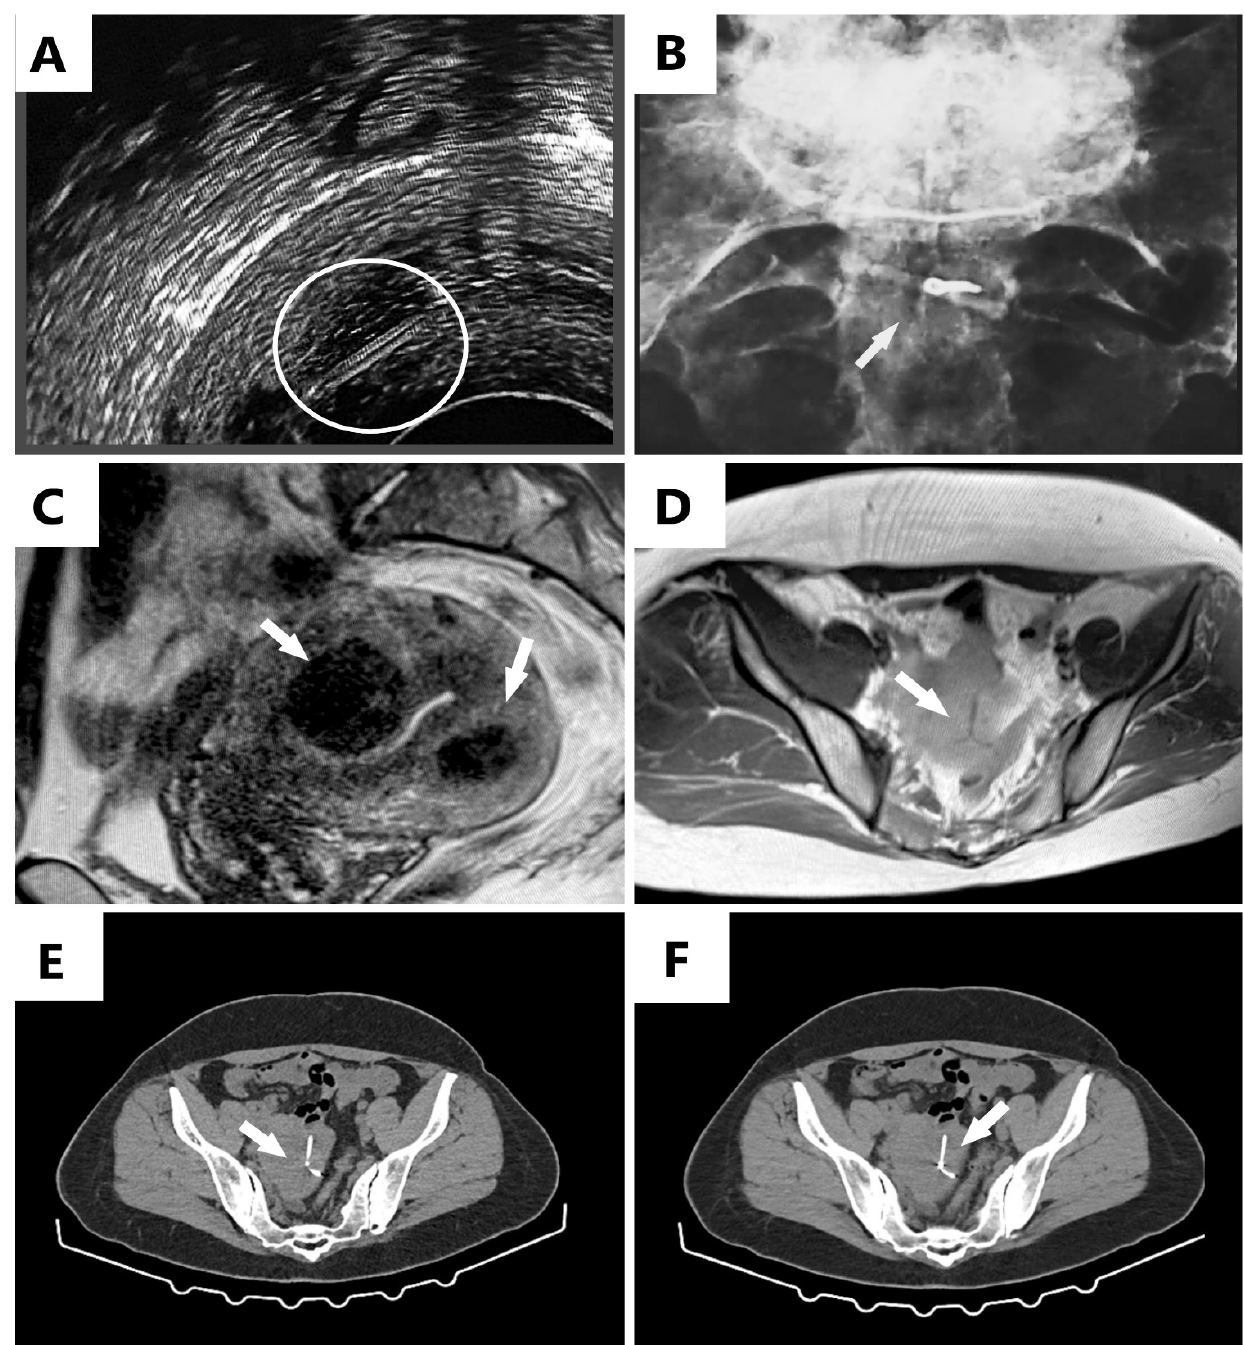
Figure 1. ( A ) Ultrasound examination revealing the control strings of the IUD, initially mistaken for a migrated device marked inside the white circle; ( B ) plain pelvic X-ray revealing the round area of the IUD where the control strings were normally attached (white arrow); ( C , D ) magnetic resonance imaging (MRI) scans revealing the uterus with two fibroids (white arrows) and no identified IUD ( C ), and the intramural IUD with a vicious position (upside-down), identified near the serosa (white arrow) ( D ); ( E , F ) computed tomography (CT) scan revealing the IUD adjacent to the serosa and lumbosacral plexus (white arrows). A 45-year-old G4P2 woman was seen in our clinic for levonorgestrel (LNg) intrauterine device (IUD) removal according to the medical instructions, having been used for menstrual management. After the insertion of the intrauterine device (IUD), the patient was subsequently followed up with by the gynecology service. Her past medical history included lumbar discopathy surgery and multiple uterine fibroids, larger than 5 cm in diameter. At the time of admission, the main complaints were about abdominal discomfort, low back pain corresponding